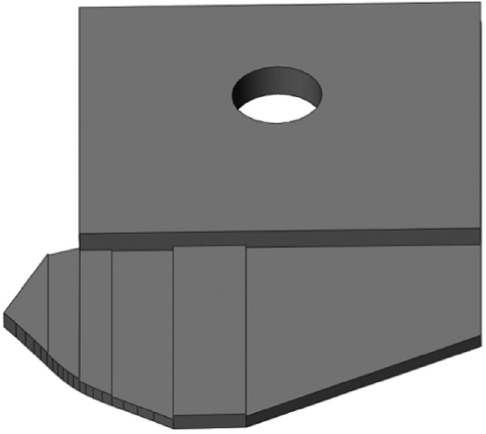
FIG. 13. Correction shim profile. The machined shape is composed of six slots with different thickness. The shim material is steel AISI